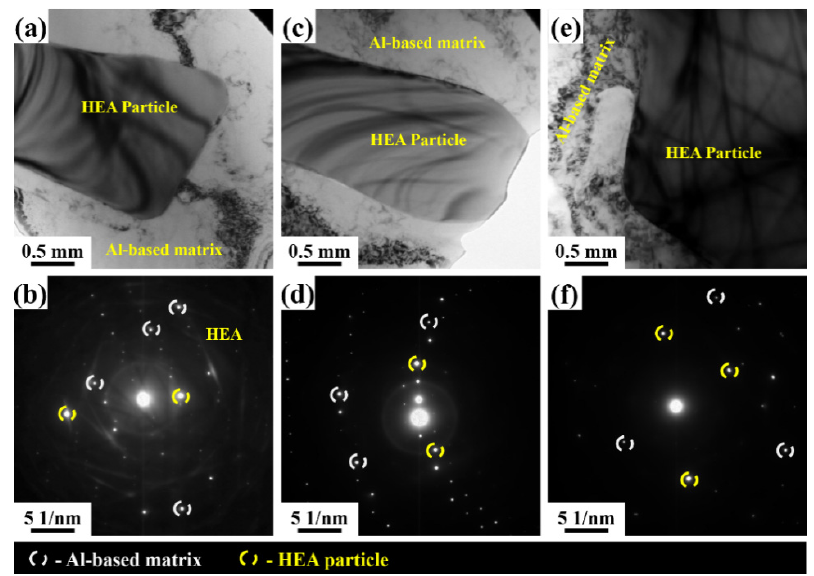
Figure 7. Transmission electron microscopy images of Al 6063–5 wt.% HEA composite: ( a ) bright-field image and ( b ) its corresponding selected area diffraction pattern. Transmission electron microscopy images of LM25–5 wt.% HEA composite: ( c ) bright-field image and ( d ) its corresponding selected area diffraction pattern. Transmission electron microscopy images of LM25–10 wt.% HEA composite: ( e ) bright-field image and ( f ) its corresponding selected area diffraction pattern.